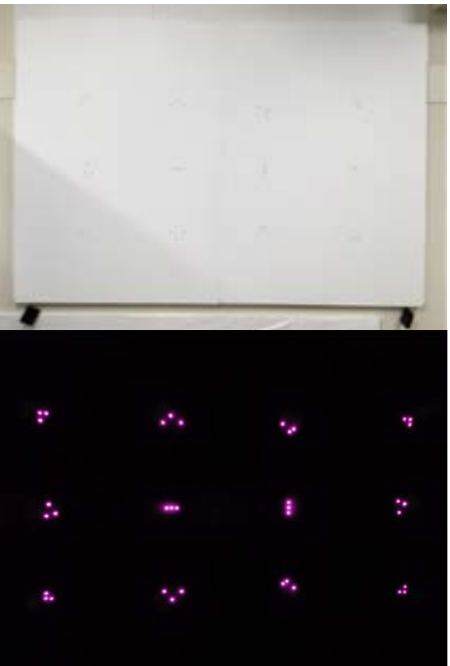
Figure 7: IR Marker-embedded screen as seen with the naked eye (top) and through a filter